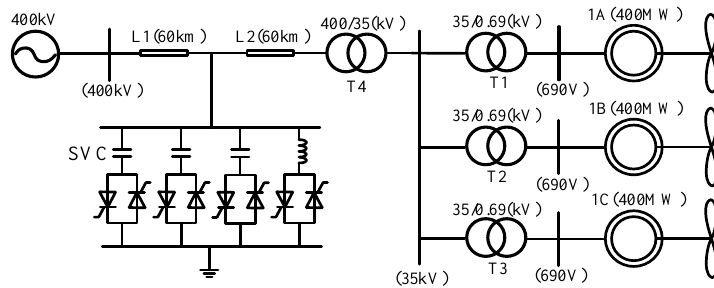
Figure 6. Structure of Hornsea wind farm.